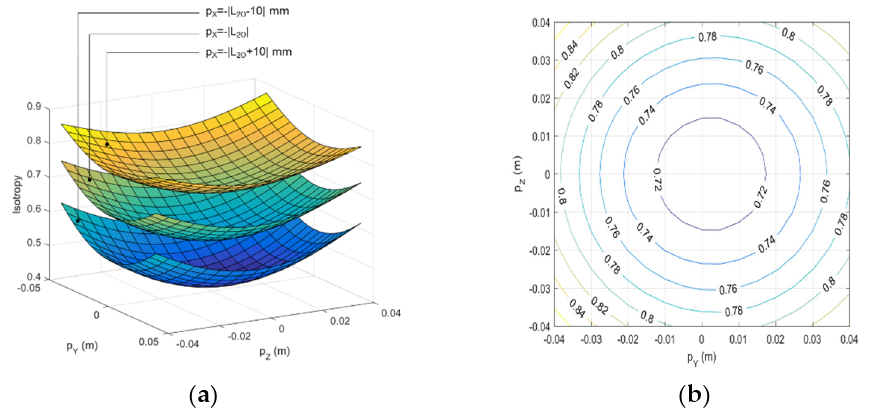
Figure 8. Isotropy: ( a ) oblique view; ( b ) contour map.